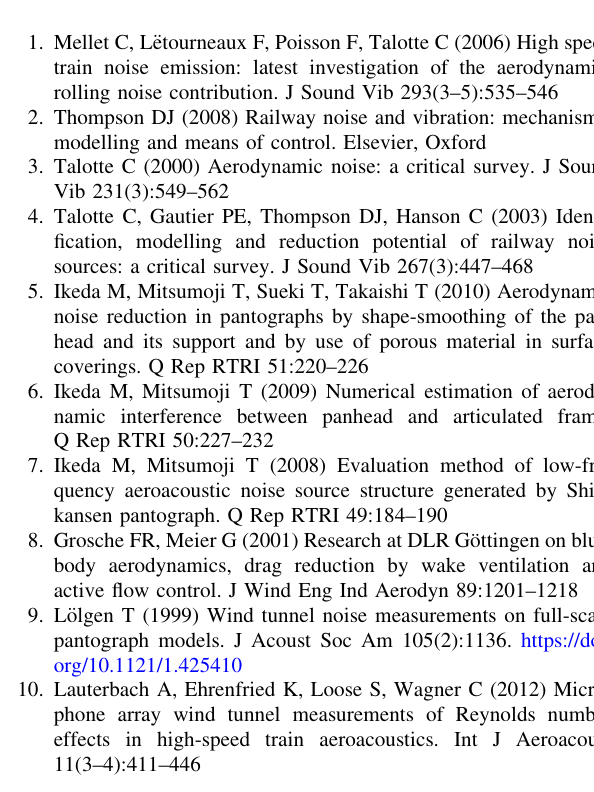
Table 7 Sound power levels (re 10 (cid:7) 12 W) from cases 1 and 2 with a rectangular cavity and cases 3 and 4 with the rounded cavity Simulation